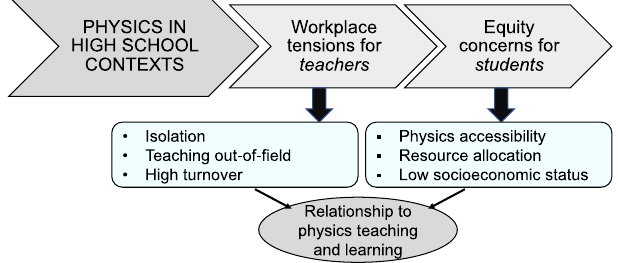
FIG. 1. Theoretical considerations for examining the challenges of teaching and learning physics in high school